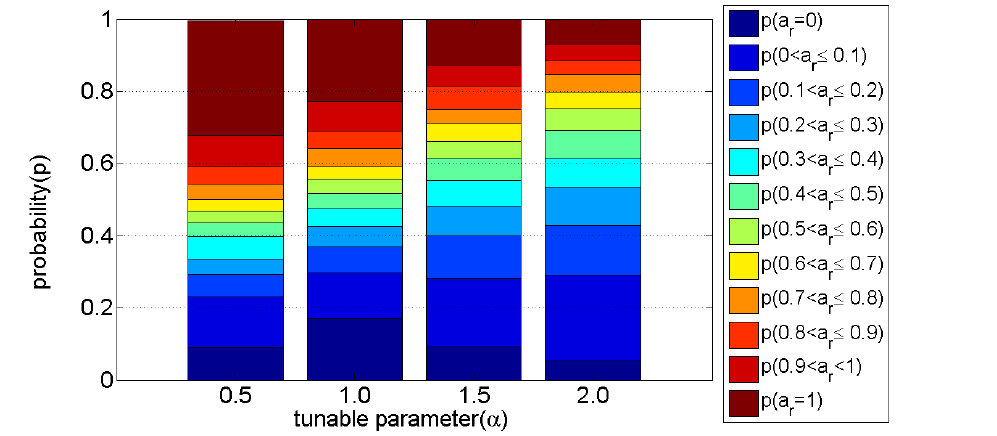
Figure 4. Probabilities of cascading failures in the Indian power grid under natural failure